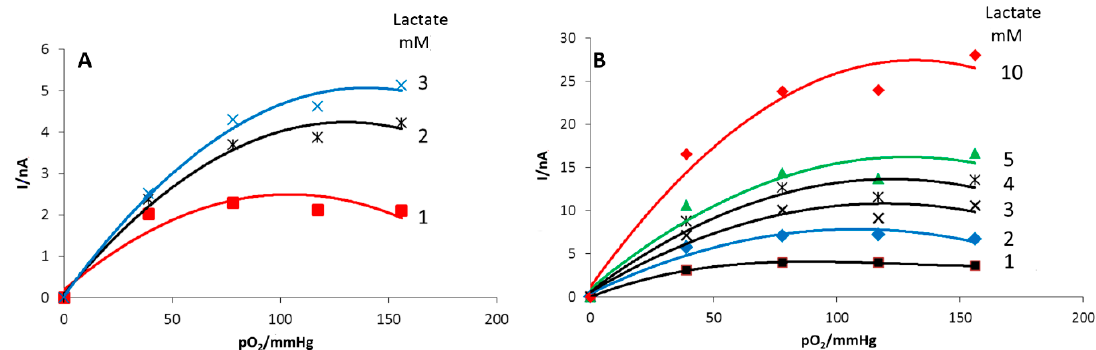
Figure 7. Oxygen dependence of the lactate needle response to different lactate levels. ( A ) sensor without a polyurethane barrier layer ( B ) sensor with a 20,30% polyurethane external membrane coating.